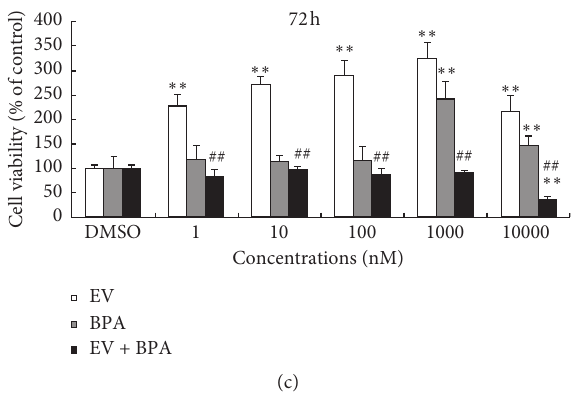
Figure 3: The binary joint effect of EV and BPA on cell viability of MCF-7 cells. Exposure time: (a) 24h; (b) 48h; (c) 72h. Data points represent mean ± SD of three independent experiments. ∗ p < 0 . 05, ∗∗ p < 0 . 01, compared with DMSO; ## p < 0 . 01, compared with EV treatment.